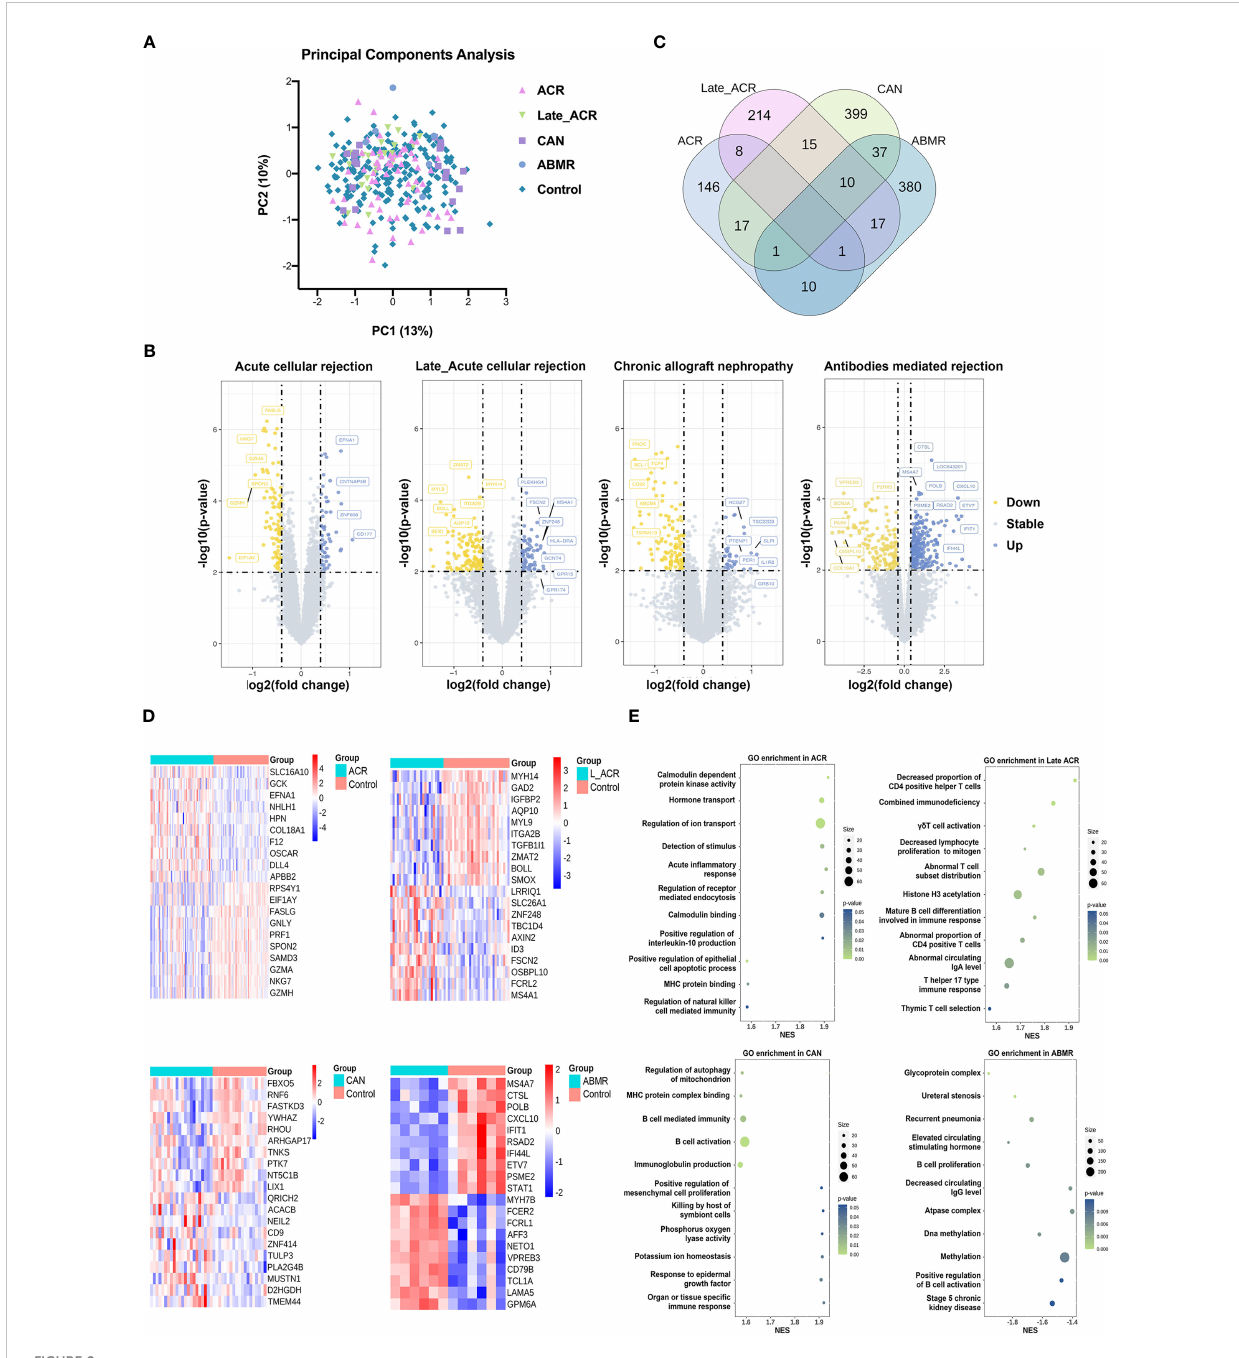
FIGURE 2 Transcriptome signature of PBMCs for kidney transplantation rejections. (A) Principal component analysis indicated the unde fi ned gene expression signature in ACR, late ACR, CAN and ABMR. (B) Volcano plots show differently expressed genes between rejected and control samples in each rejection. (C) The Venn diagram reveal the common DEGs among groups. (D) Clustering heat maps demonstrate expression levels of 20 robust DEGs in different rejection samples. (E) The GO pathway enrichment shows the various biological processes in PBMCs. ACR, acute cellular mediated rejection; CAN, chronic allograft nephropathy; ABMR, antibodies-mediated rejection. GO, Gene